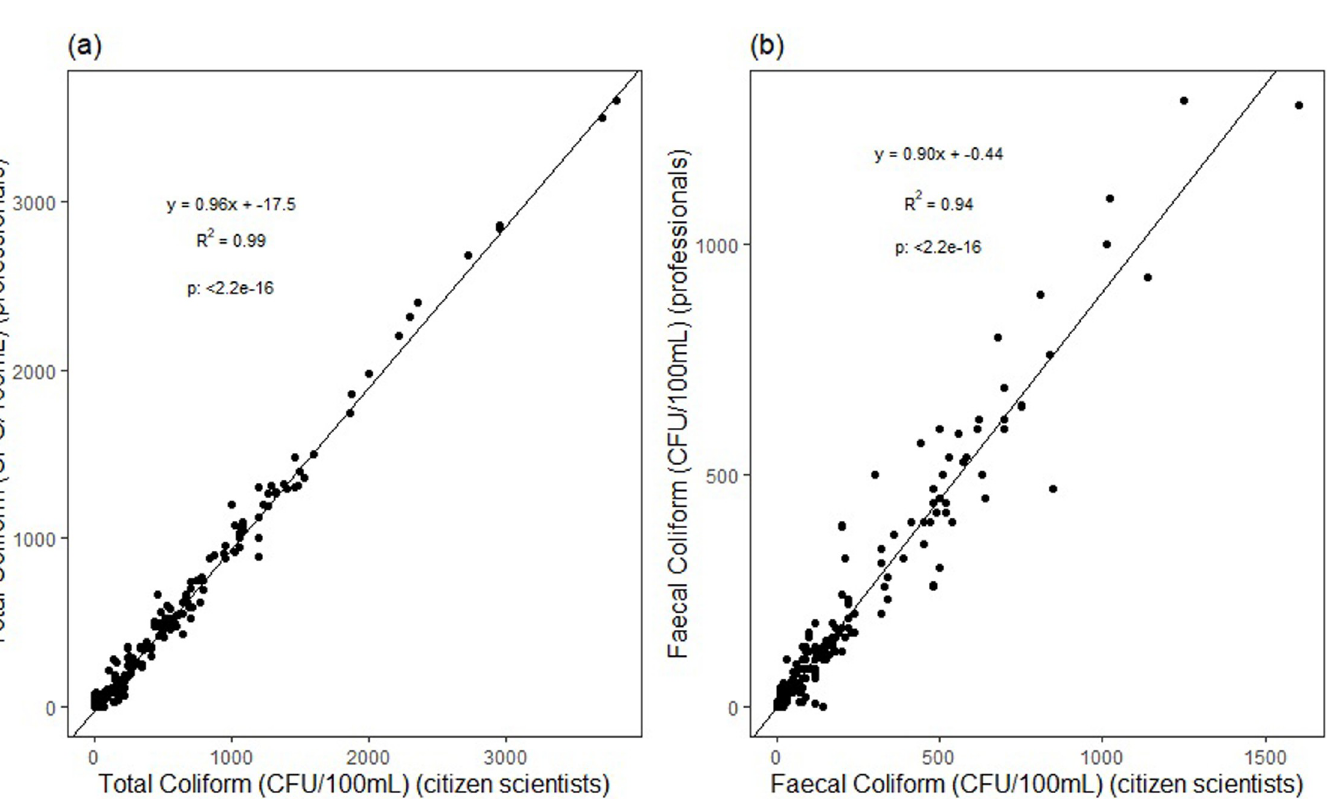
Fig 5. Pearson correlation of total coliform and fecal coliform concentration (CFU/100 mL) observed by professional and citizen scientists (a) Total coliform (CFU/100 mL) (b) fecal coliform (CFU /100m/L) (n = 180).